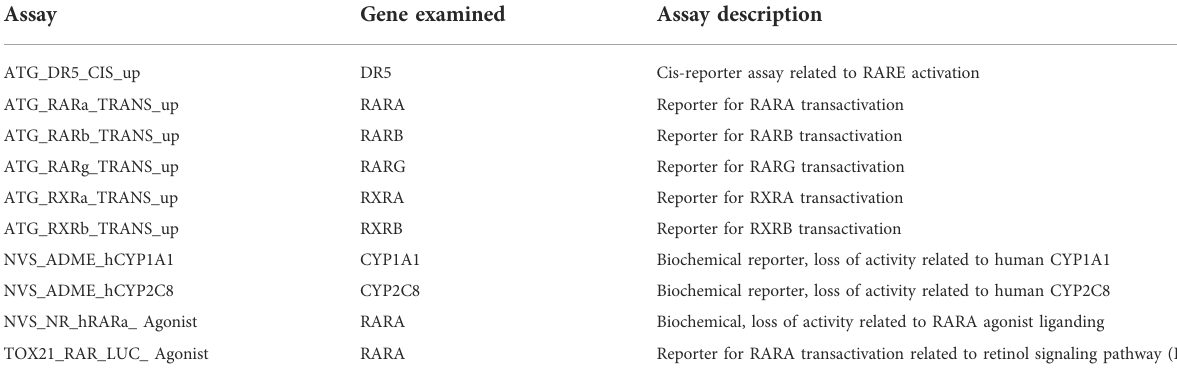
TABLE 1 | The 10 ToxCast and Tox21 assays that tested over 8,079 chemicals for bioactivity for relevant ATRA.